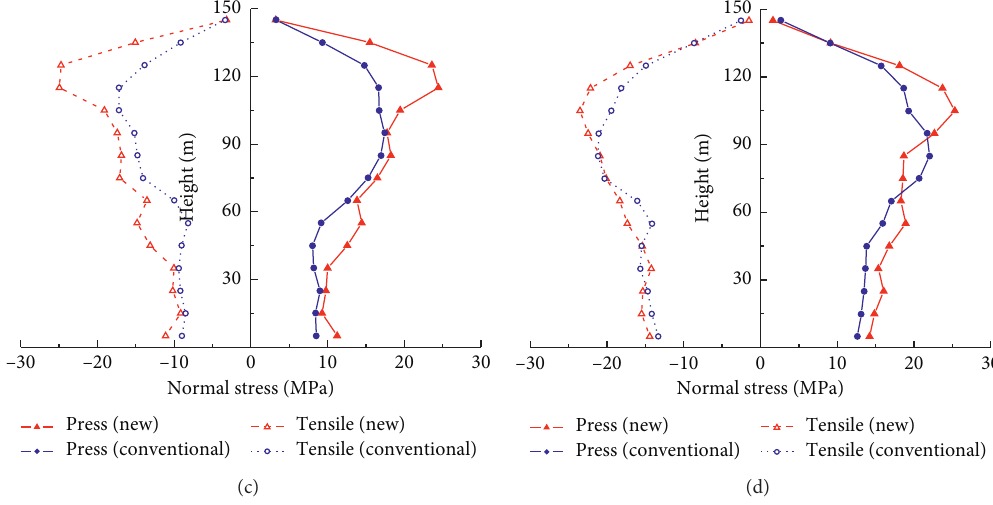
Figure 7: Spatial distributions of maximum earthquake normal stresses at different cross sections of the 150m high chimney under four earthquake wave actions: (a) Landers wave (No.1 in Table 1); (b) Loma Prieta wave (No. 2); (c) Borrego wave (No. 3); (d) Chichi wave (No.